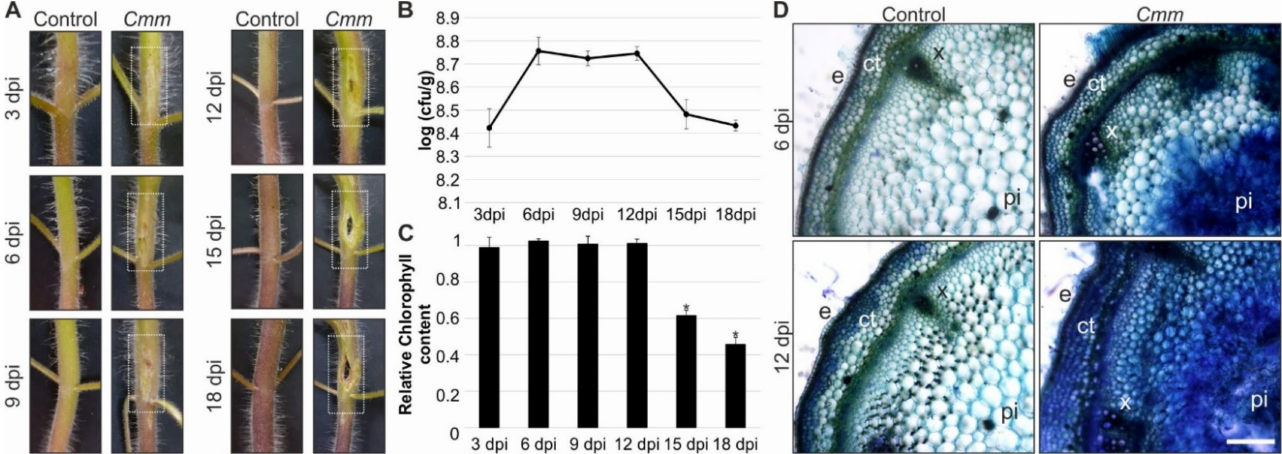
Figure 1. Disease symptoms in tomato plants infected with Cmm . ( A ) Bacterial canker lesions on inflorescence stems at 3, 6, 9, 12, 15 and 18 dpi. The dashed boxes in white indicate the symptoms. ( B ) Bacterial growth in tomato stem samples, which were harvested at different time points during an 18-day period after inoculation. Data represent the mean ± SD (n = 4). ( C ) Effect of Cmm infection on total chlorophylls of the true leaves. The relative chlorophyll content was calculated by comparing the concentration of chlorophylls quantified in mg/g of fresh weight between Cmm infected and control plants. Data are shown as means ± SD (n = 3). Asterisks indicate significant differences ( t -test) between Cmm infected and control plants ( p ≤ 0.05). ( D ) Trypan blue stained cross-sections at 6 and 12 dpi stems of tomato plants; e: epidermis, ct: cortex, x: xylem, pi: pith. (Scale bar = 500 µ